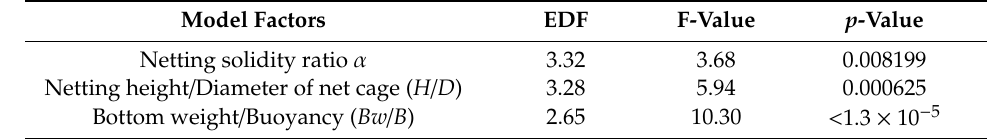
Table 3. Statistical results of GAM analysis for volume holding ratio.